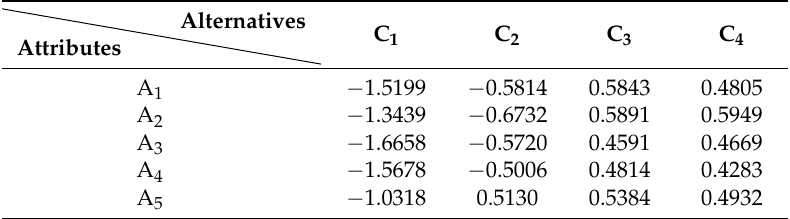
Table 3. The prospect values of alternatives with